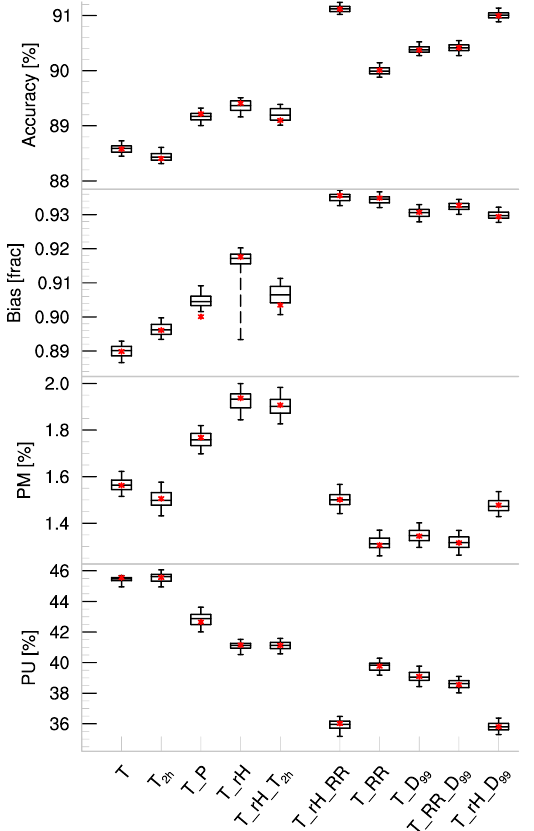
Figure 4. Box-and-whisker plot displays interquartile spread (black box: 25th, 50th, and 75th percentile) and lower (whisker: 5th per- centile) as well as upper (95th percentile) extremes, calculated from 100 realizations of each 50% randomly chosen minutes of precip- itation from RS sub-data. Red stars denote the values for 100% of RS sub-data. Accuracy (%), bias score (frac), percentage mis- classified (PM: fraction of disagreeing cases with high certainty of p > 0 . 95 in %), and percentage unclassified (PU: fraction of uncer- tain cases of 0 . 05 < p < 0 . 95 in %) serve as performance scores using the calculated coefficients in Table 4 against the manually de- termined PP reference data. Labels indicate variable combinations, whereby all combinations include T